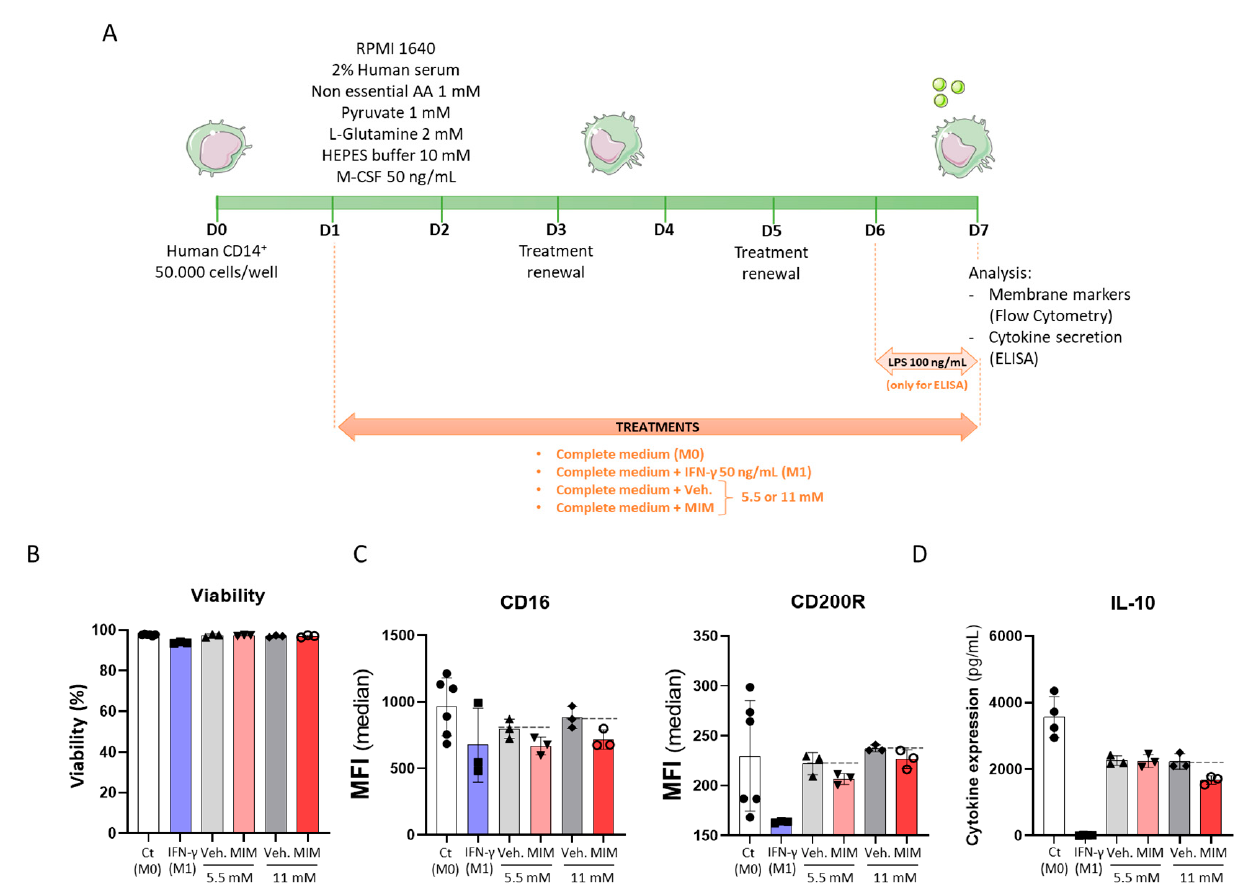
Figure 2. MIM modulates CD16 and CD200R expression and IL-10 secretion of CD14 + -derived mac- rophages in vitro without affecting the cell viability. ( A ) Representative scheme of the experimental protocol. CD14 + cells were obtained from PBMCs isolated from one healthy donor and cultivated for 6 days in complete medium supplemented with M-CSF 50 ng/mL (M0) and in presence of either MIM or vehicle at 5.5 or 11 mM. CD14 + cells cultivated in complete medium in which M-CSF 50 ng/mL and IFN- γ 50 ng/mL were added served as a positive control towards M1 macrophage- differentiation (M1). A 24 h LPS treatment (100 ng/mL) was applied for the ELISA test as an inducer of an inflammatory status. Viability and cell surface marker expression were assessed by flow cy- tometry and IL-10 concentration was evaluated by ELISA. AA: amino acids. ( B ) Effects of MIM on cell viability. The cell viability was assessed by flow cytometry, as the NIR-Zombie positive cells. ( C ) Effects of MIM on the expression of the cell surface markers CD16 and CD200R and ( D ) the secretion of IL-10. Data are represented as mean ±